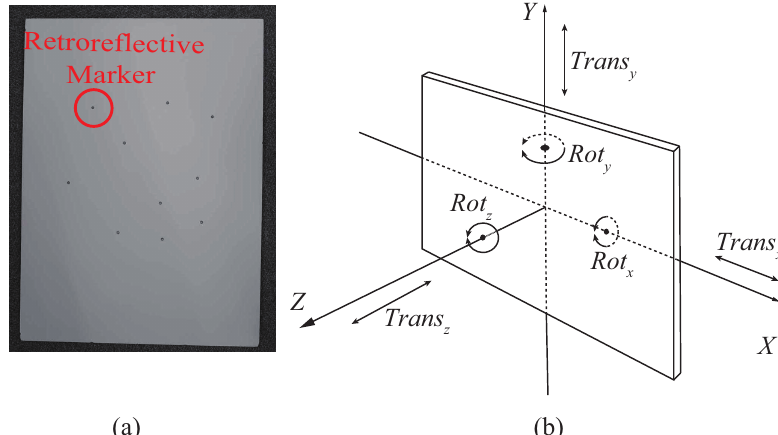
Figure 4. ( a ) Calibration object, a white board with ten randomly but asymmetrically placed retroreflective markers. ( b ) Six motion patterns of the calibration object in its local co-ordinate system, of which the calibration data are